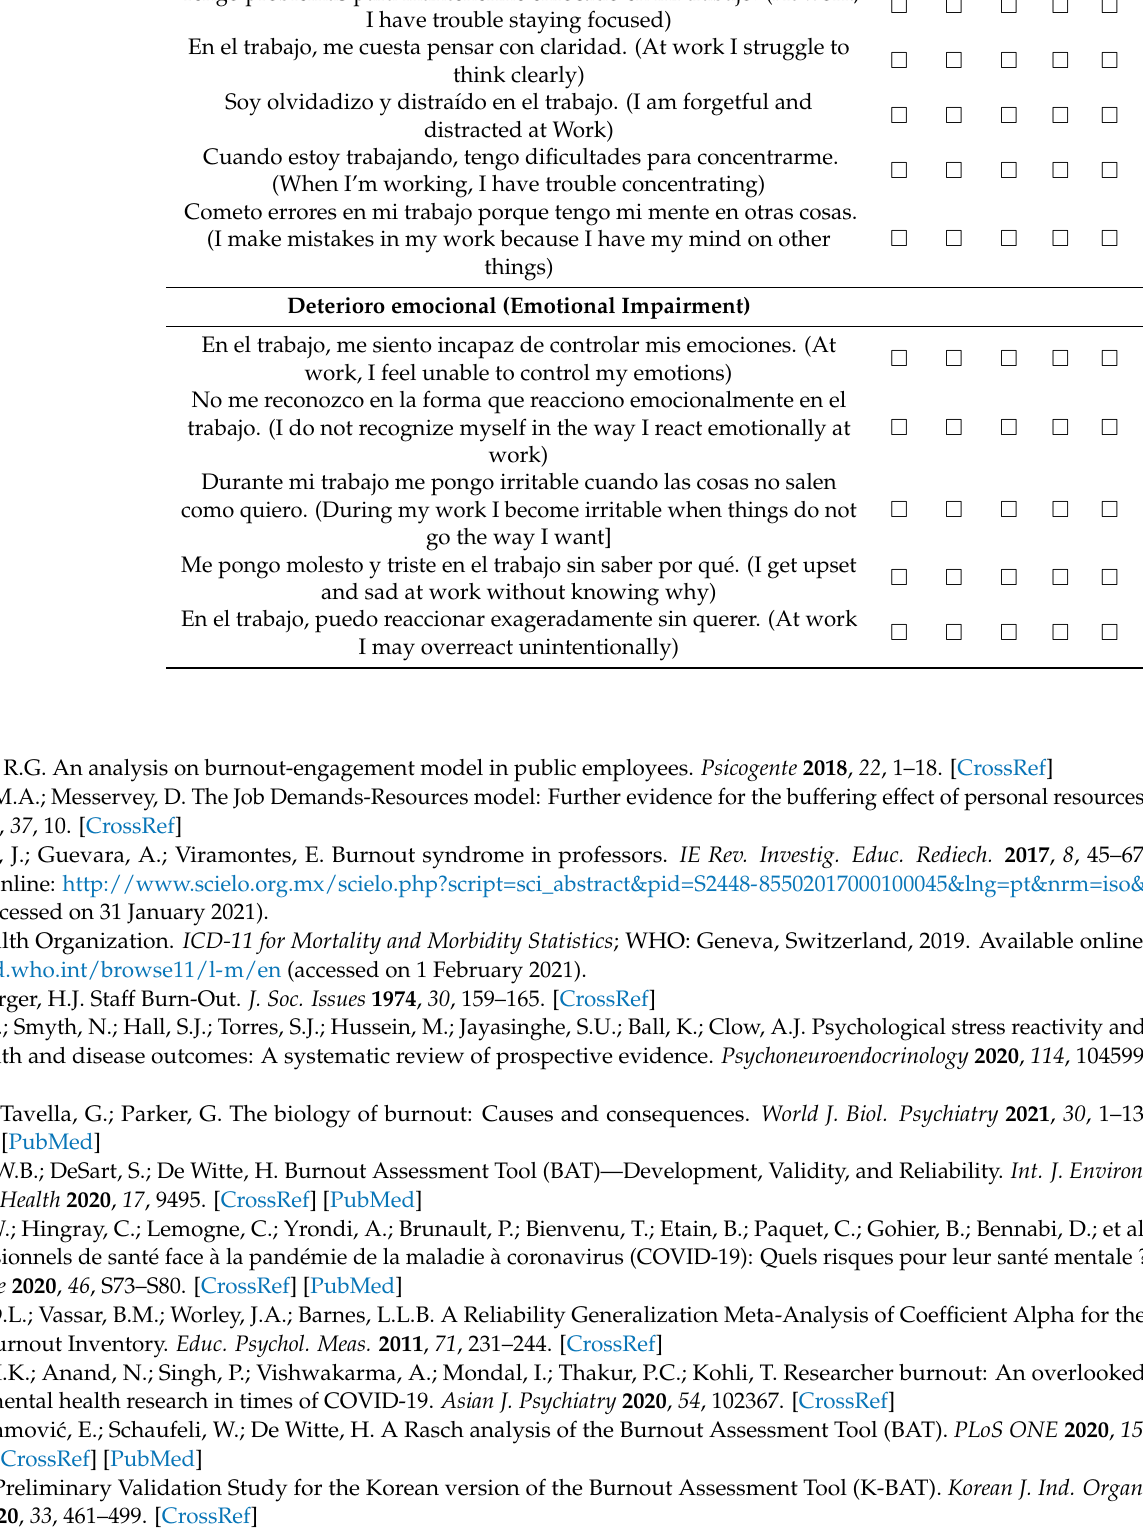
Table A2. Cont. Nunca Raramente Algunas veces (Never) (Rarely) Deterioro cognitivo (Cognitive Impairment) Tengo problemas para mantenerme enfocado en mi trabajo. (At work, I have trouble staying focused) think